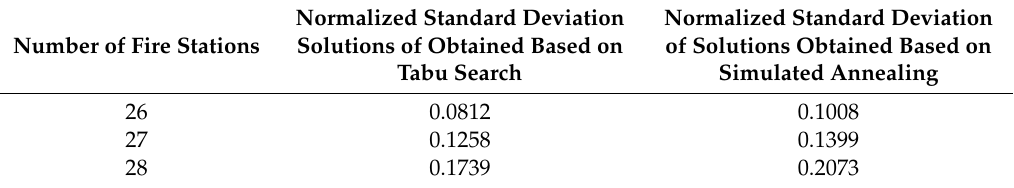
Table 22. The normalized standard deviation of solutions obtained using the VAOCMP model with both algorithms.